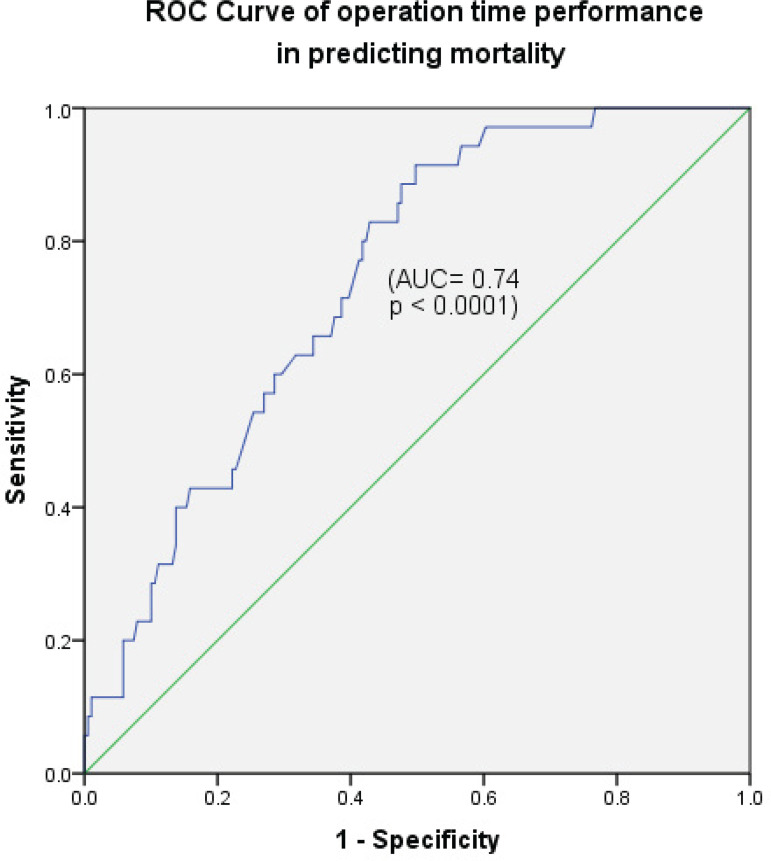
Cutoff point of 511.5 minutes (8.525 hours) had an accuracy of 74.1% in predicting mortality (sensitivity 73.3%, specificity 60%, P<0.0001). AUC=area under the curve; ROC=receiver operating characteristics